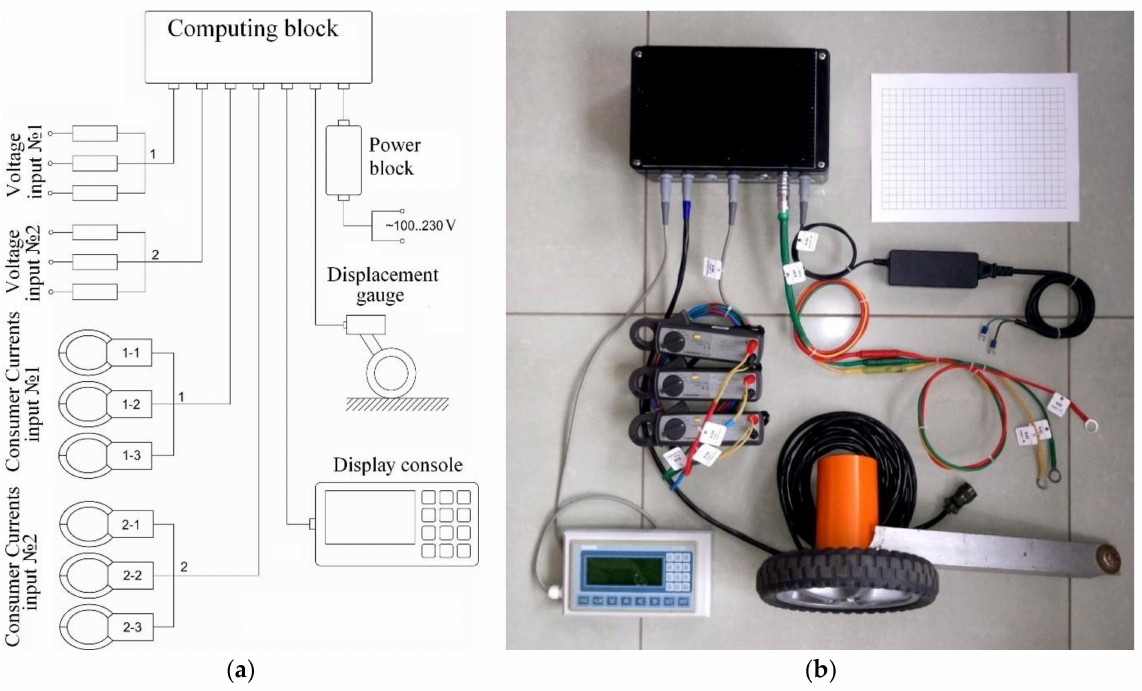
Figure 3. Block diagram ( a ) and general view ( b ) of the VATUR